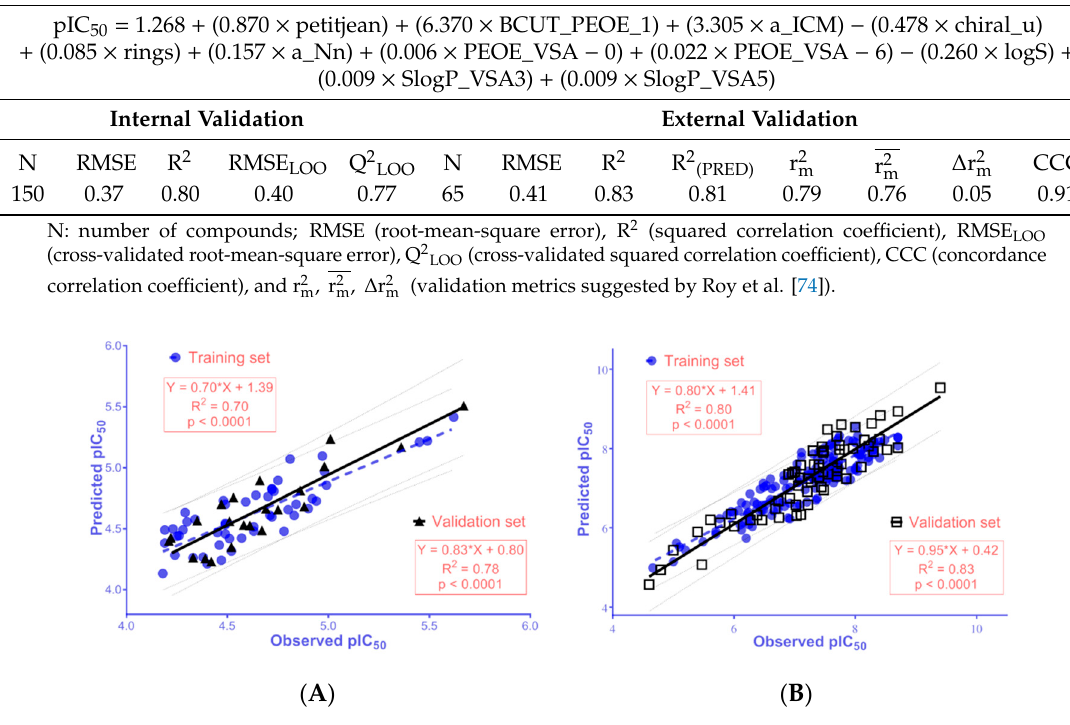
Figure 4. The linear regression between observed pIC 50 and those predicted from the 2D-QSAR models for inhibitors of ( A ) AChE and ( B ) BACE-1. for inhibitors of ( A ) AChE and ( B )